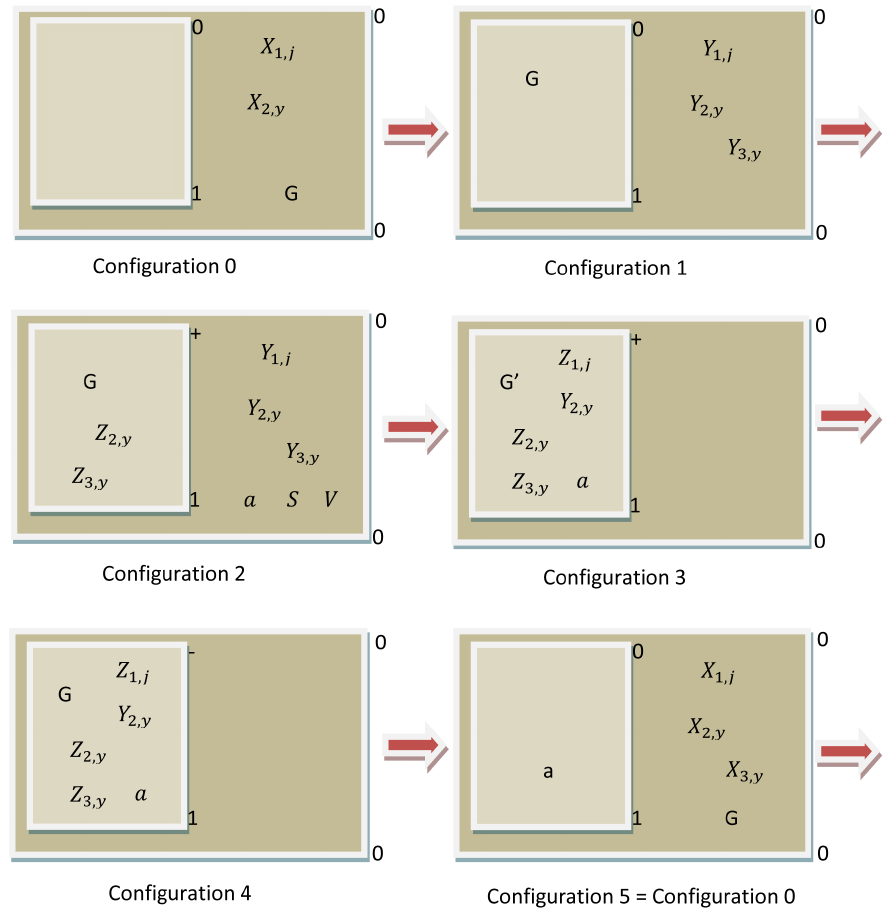
Figure 5. Types of configurations that appear in the execution of a loop of the model. The representation shows the types of objects that